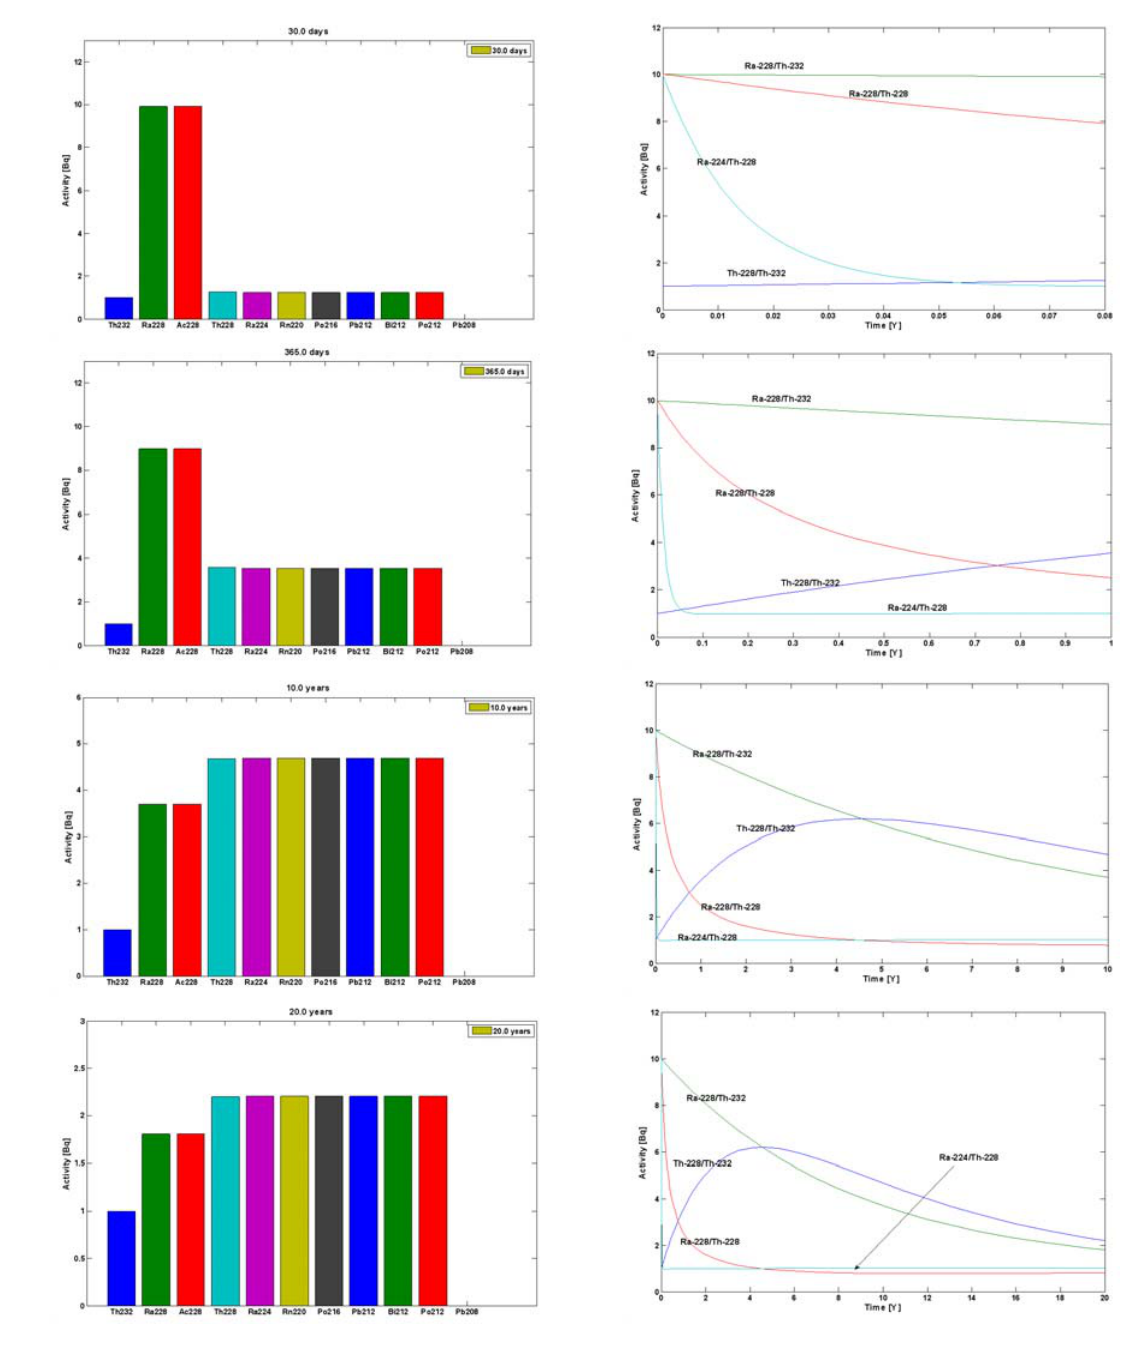
Fig. 9 Simultaneous decay of thorium and radium isotopes in the 232 Th decay chain over time period of 100 y. Initial activities are: 232 Th 1 Bq, 228 Th 1 Bq, 228 Ra 10 Bq and 224 Ra 10